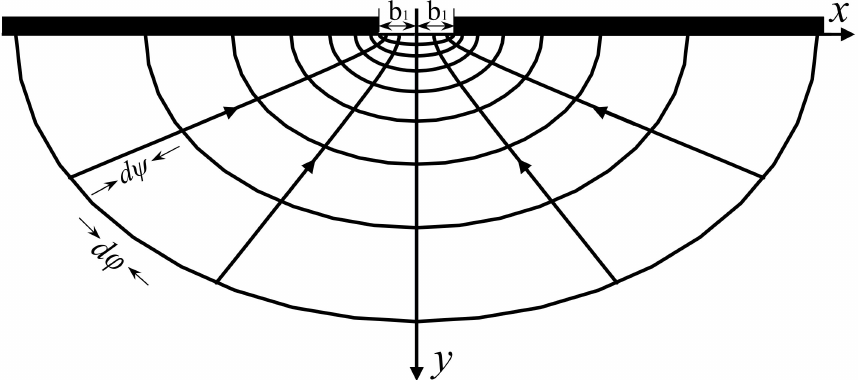
Figure 4. Plot of the flow net distribution with Wu’s model. (Note: d ψ is the increment of the potential function, and d ϕ is the increment of the stream